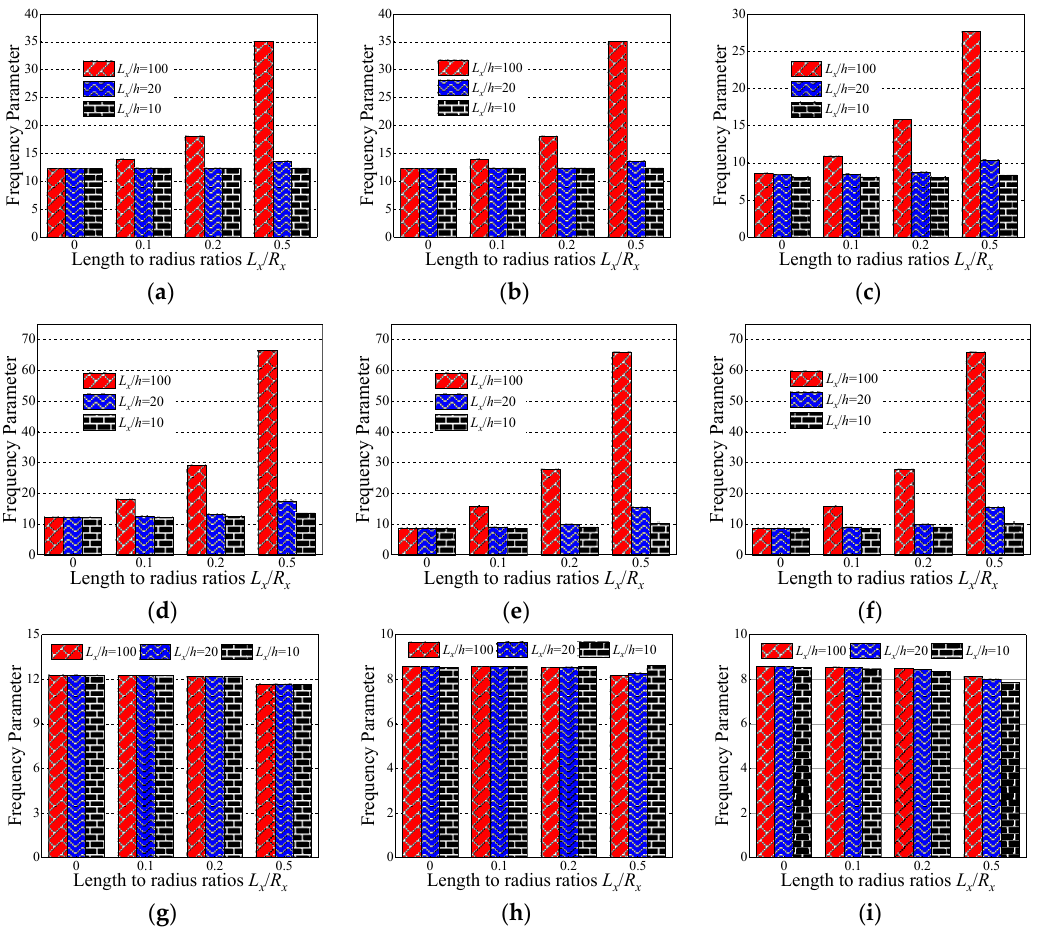
Figure 4. Variation laws of the fundamental frequency parameter Ω for composite laminated shallow shells with the SD-SD boundary condition with respect to various length to radius ratios L x / R x and length to thickness ratios L x / h by first-order shear deformation shell theory (FSDT). ( a ) Cylindrical shell, 0 ° /90 ° /90 ° /0 ° ; ( b ) cylindrical shell, 0 ° /90 ° ; ( c ) cylindrical shell, 90 ° /0 ° ; ( d ) spherical shell, 0 ° /90 ° /90 ° /0 ° ; ( e ) spherical shell, 0 ° /90 ° ; ( f ) spherical shell, 90 ° /0 ° ; ( g ) hyperbolic paraboloidal, 0°/90°/90°/0°; ( h ) hyperbolic paraboloidal, 0°/90°; ( i ) hyperbolic paraboloidal, 90°/0°.